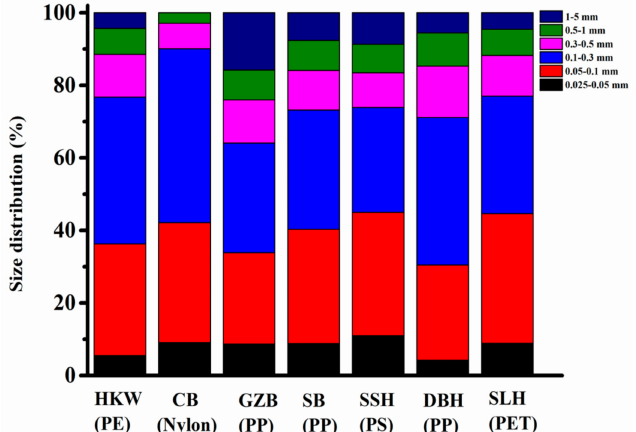
Figure 4. The size distribution of microplastics found in takeaway containers. The particles are divided into 6 size ranges: 0.025–0.05 mm, 0.05–0.1 mm, 0.1–0.3 mm, 0.3–0.5 mm, 0.5–1 mm and 1–5 mm.